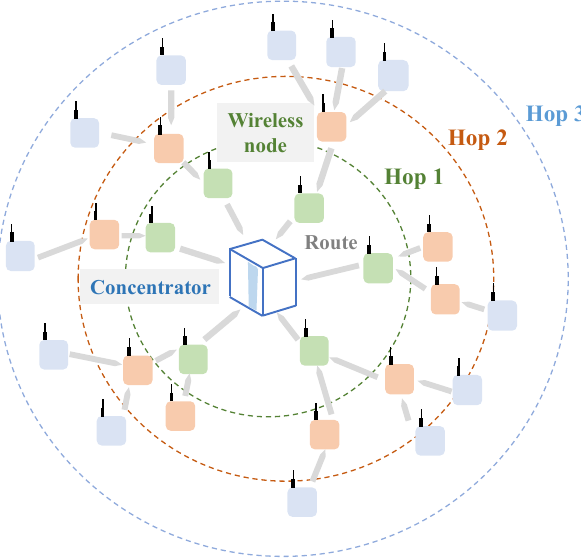
Figure 1. System organization of the Low-Power Wireless Sensor